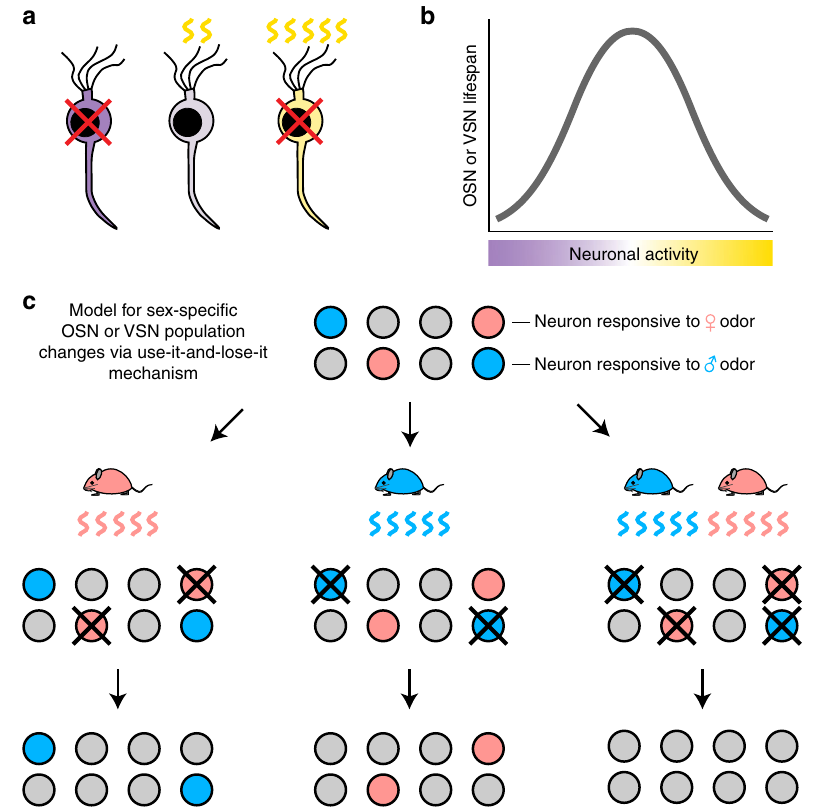
Fig. 7 Model for how OSN and VSN subtypes become differentially abundant in SF and SM mice. a Very low (violet) or very high (yellow) levels of activity may shorten OSN/VSN lifespan, while a moderate (gray) level of activity may lengthen their lifespan. b An optimal range of neuronal activity may be required to maximize OSN/VSN lifespan. Distinct OSN/VSN subtypes may be affected differently by olfactory manipulation due to differences in their basal level of activity. c Schematic for how the distinct olfactory environments experienced by sex-separated females and males may induce differences in the abundance of OSN/VSN subtypes (for simplicity, only the use-it-and-lose-it mechanism is shown). Initially, an individual ’ s OSN/VSN populations contain neuron subtypes that are responsive to odors speci fi c to female mice (pink circles), male mice (blue circles), or neither (gray). Upon sex separation of females (left) or males (middle), OSNs/VSNs that are responsive to female-speci fi c or male-speci fi c odors, respectively, are chronically stimulated and thus selectively depleted from the population. Under sex-combined conditions (right), OSNs/VSNs that are responsive to both female-speci fi c and male- speci fi c odors are chronically stimulated and depleted from the